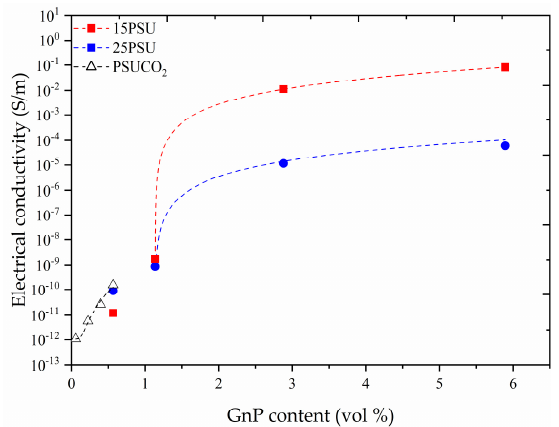
Figure 3. Evolution of the electrical conductivity with GnP content for the three foam series representing a power law fit.